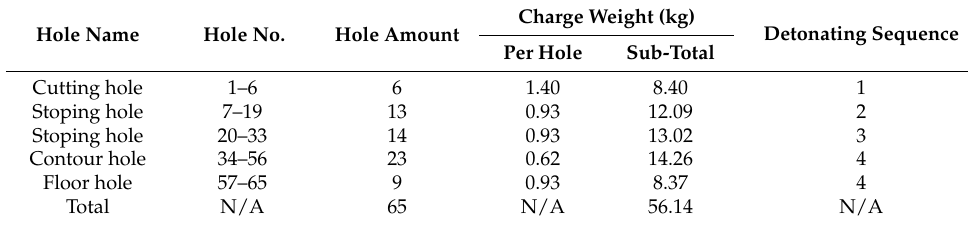
Table 5. Blasting parameters of the original scheme.